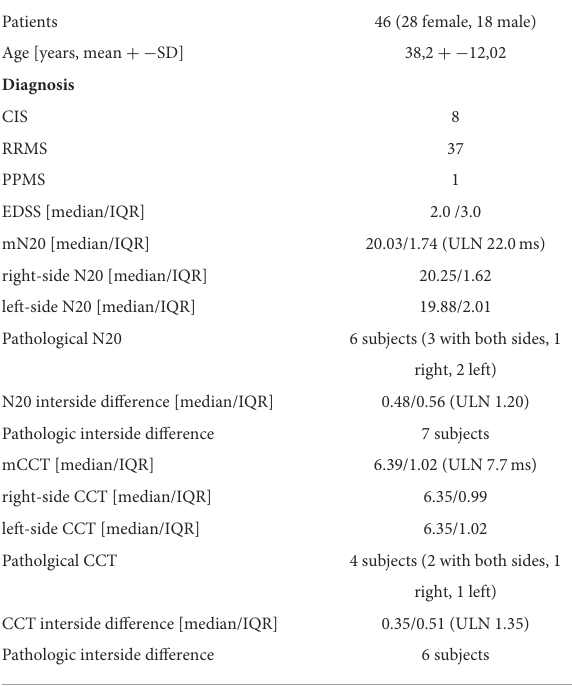
TABLE 1 Clinical characteristics of the patients.